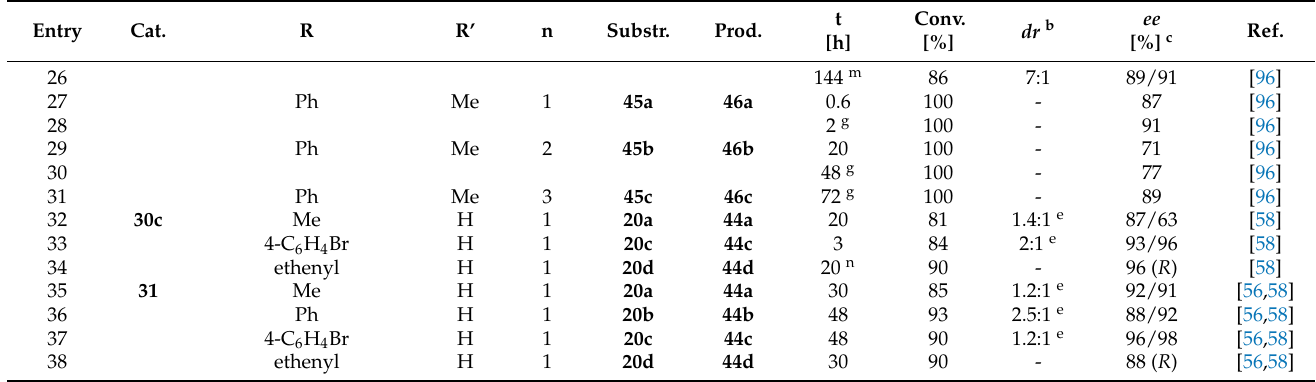
a Conditions: 10 mol-% precatalyst in benzene, ambient temperature; substrate, c = 65.4 mM. b Where not indicated otherwise, dr is given as the ratio of cis : trans. c Enantiomeric excesses (= ee ) determined by 1 H and/or 19 F NMR spectroscopy after reaction with Mosher’s acid chloride. Where the absolute configuration on the 2-position of the formed product was determined, it is given in parenthesis. For products for which the cis/trans configuration was determined, they are ordered as cis/trans. d Conditions: 3 mol-% precatalyst in benzene, 25 ◦ C. e cis/trans Configuration not emphasized for the reaction products. f Conditions: 1.5 mol-% precatalyst in benzene, ambient